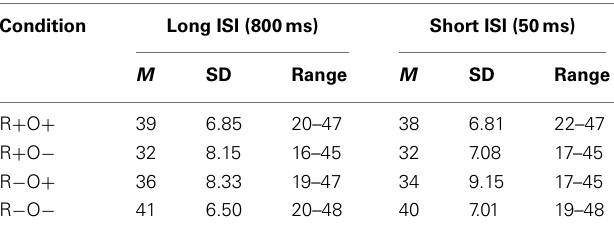
FIGURE 2 |A schematic view of the HydroCel Geodesic Sensor Net as seen from above with the nose up and neck down. The electrodes chosen for statistics extraction are shaded.The inserted table shows corresponding 20–10 system